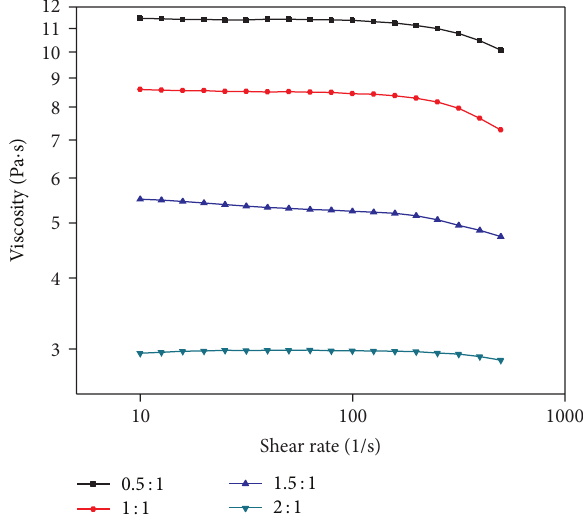
Figure11:GPCplotsofpolyolswithdifferentreactiontemperatures.